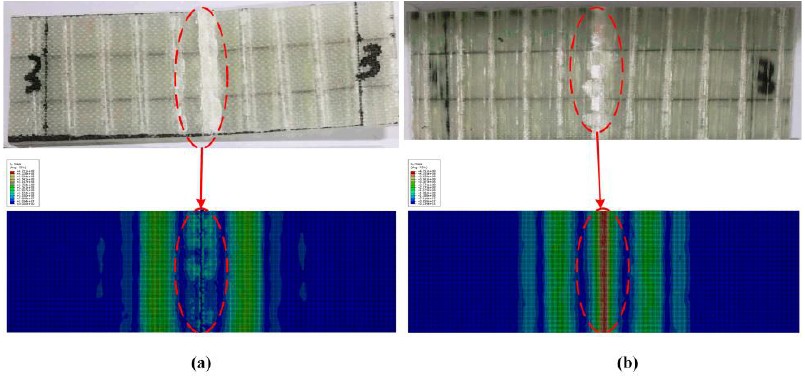
Figure 16. The failure mode of SMAHC laminate. ( a ) Compression side, ( b ) Tension side.